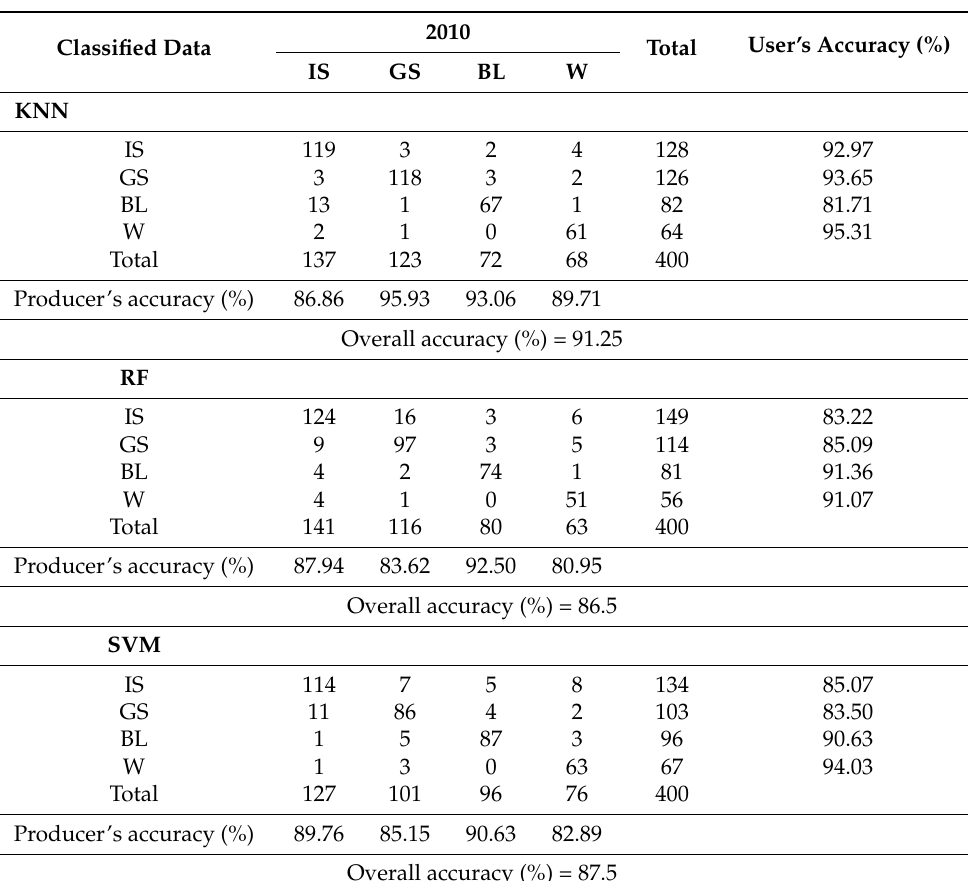
Table A3. Accuracy instructions of the classified LUC maps of